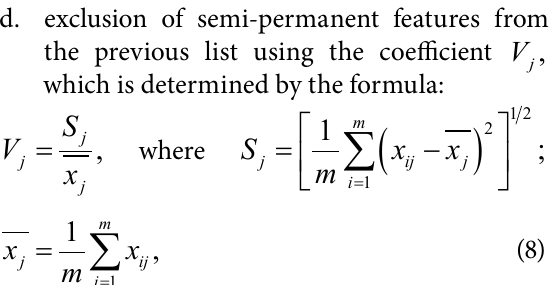
Figure 1. Consistent stages of shaping the system of estimated figures that characterize the ICI development level in the